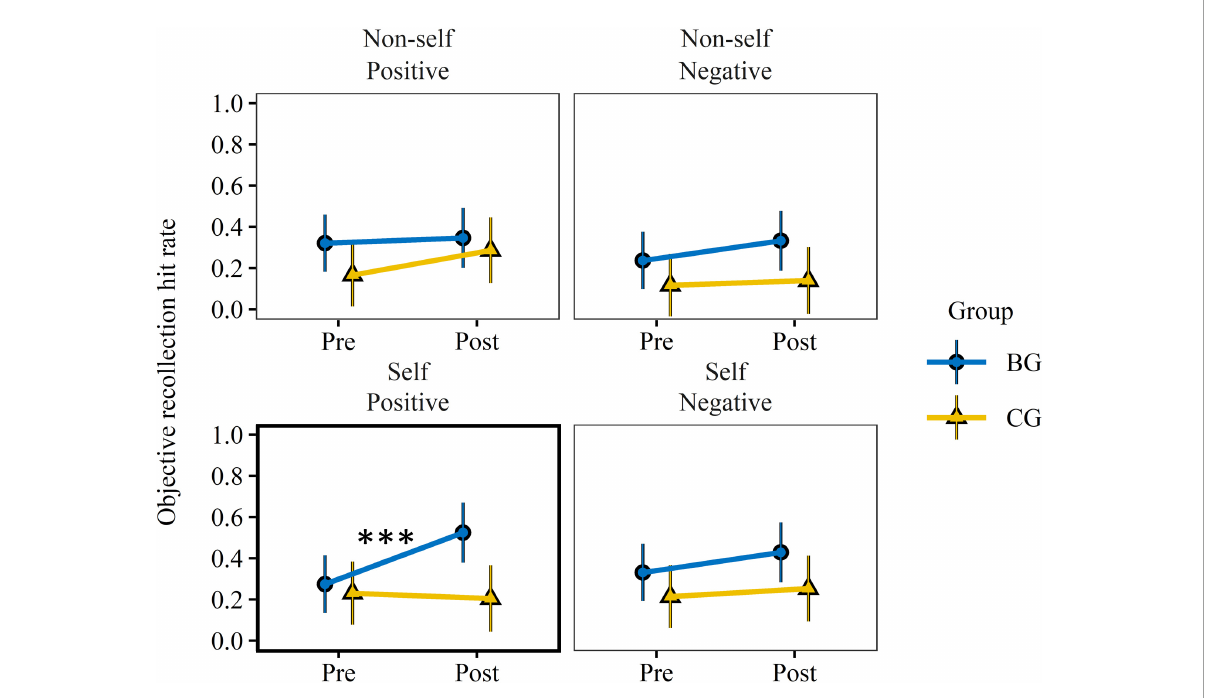
FIGURE4 Training effect on objective memory recollection. Objective recollection hit rate was assessed by the proportion of correct source recollection of studied words. EMMs and 95% CIs, derived from robust linear mixed effect models, are presented per group, reference condition, valence, and test. EMMs accounted for inter-participant differences in response reaction time at encoding and random subject effects. Pre-test values did not differ significantly ( p > 0.14) between groups. Only recollections of positive items encoded with the self-reference condition (bold frame) revealed a significant group × test interaction effect. Training related improvements were found only in the BG. BG, biofeedback group; CG, active control group; EMM, estimated marginal means. ∗∗∗ p <